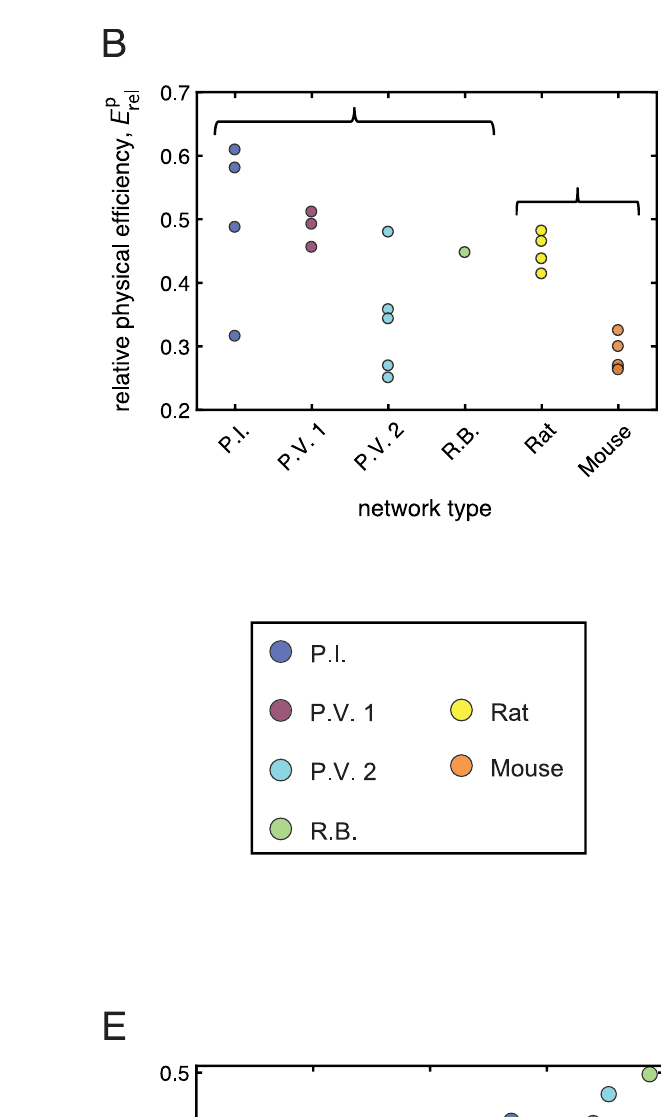
PLOS Computational Biology | https://doi.org/10.1371/journal.pcbi.1006428 September 7,